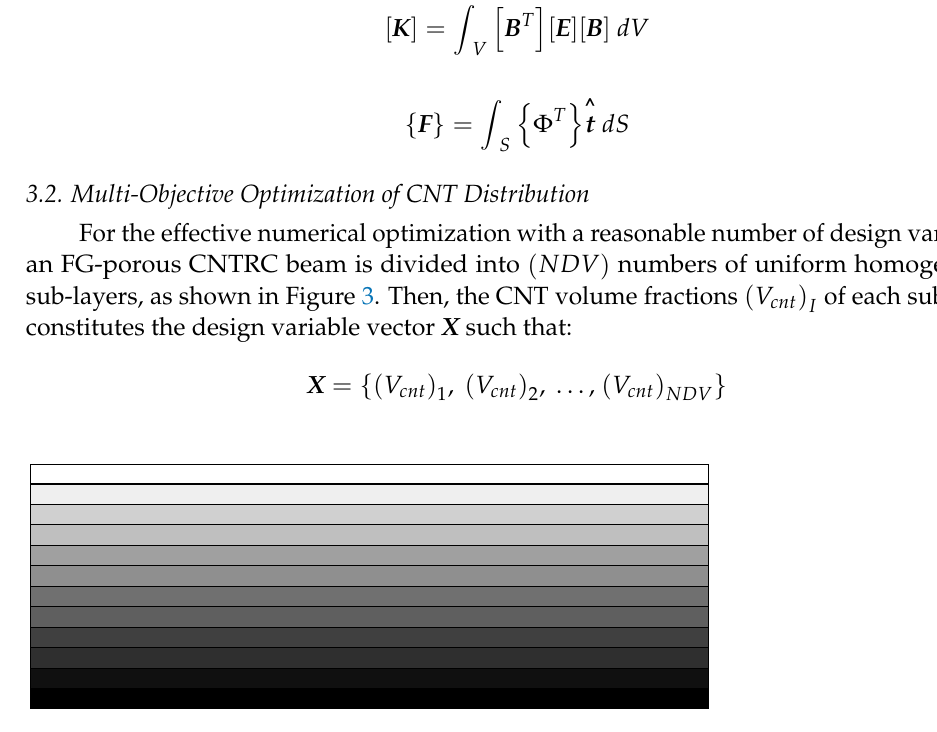
Figure 3. Uniform division of an FG-porous CNTRC beam into homogenized sub-layers.